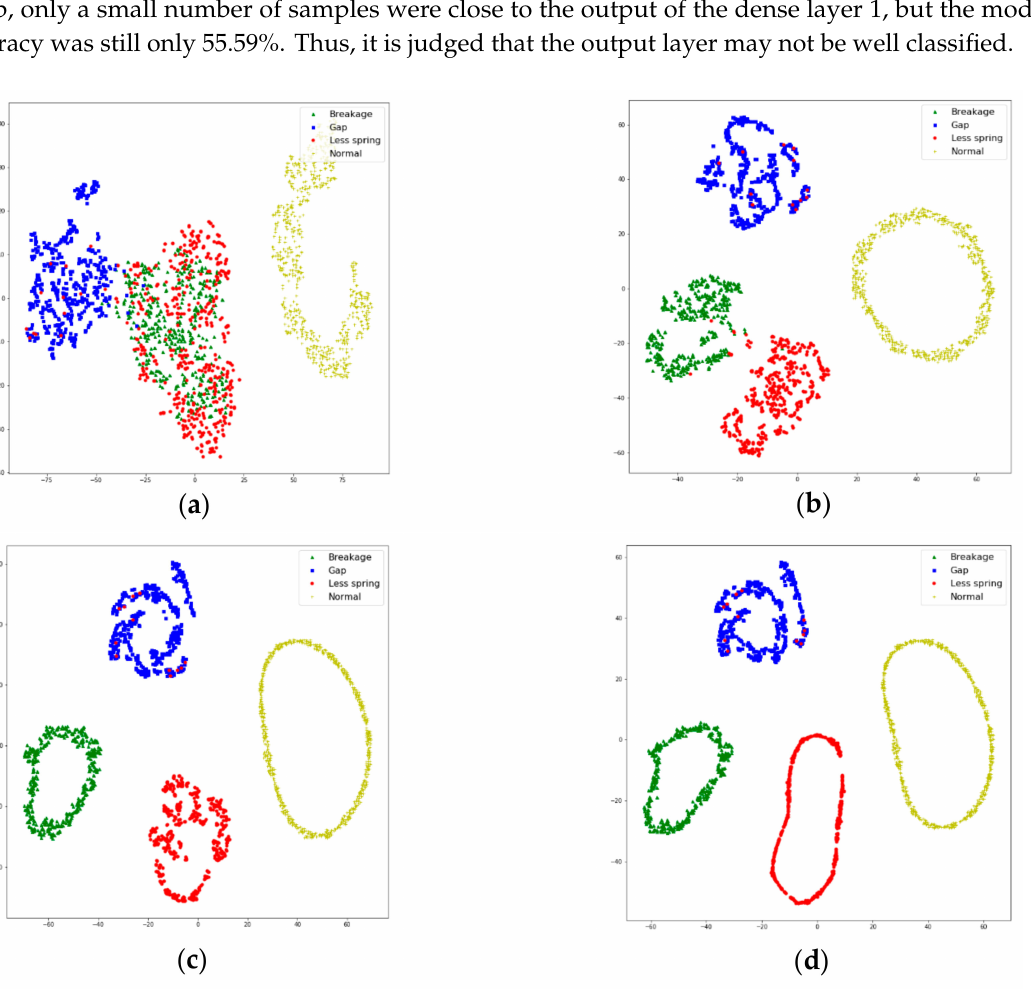
Figure 14. PCA of the output of the dense 1 of the 1-D CNN multi-point model of the test set samples under di ff erent noise strengths. ( a ) SNR is 5 dB; ( b ) SNR is 10 dB; ( c ) SNR is 20 dB; ( d ) SNR is 50